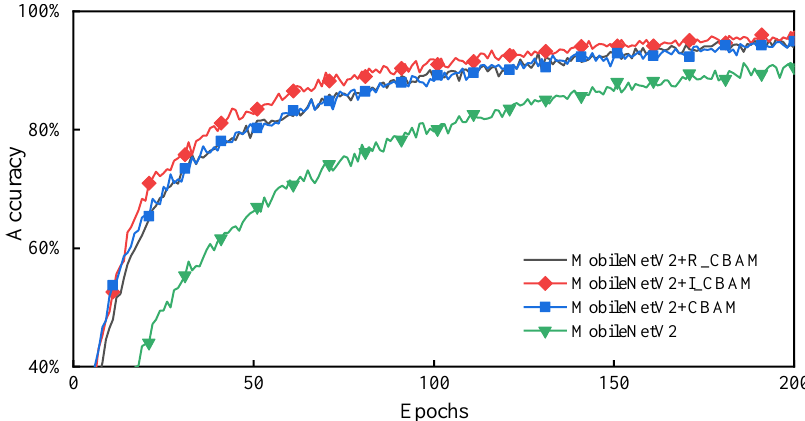
Figure 7. Accuracy comparison after embedding the attention module.